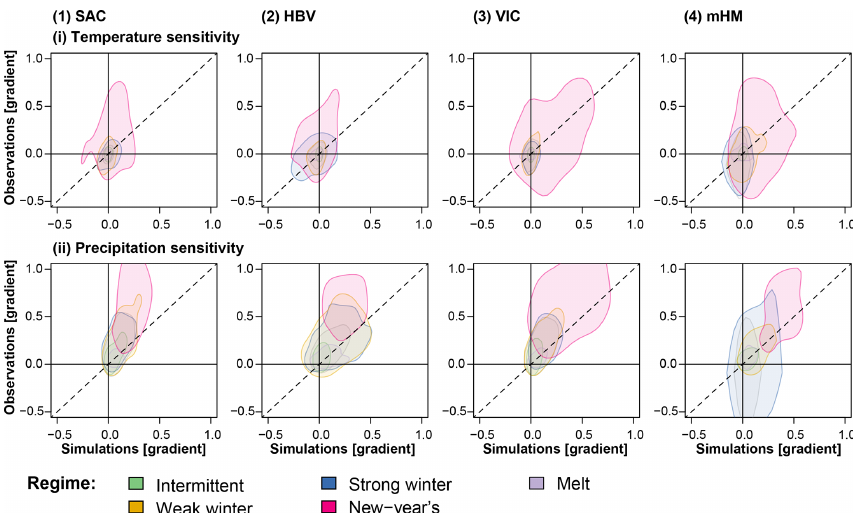
Figure 7. Observed vs. simulated (i) horizontal (temperature) and (ii) vertical (precipitation) climate sensitivities for floods represented by two-dimensional kernel density estimates for the four models (1) SAC, (2) HBV, (3) VIC, and (4) mHM for the five regime types: intermittent (114 catchments), weak winter (108), strong winter (176), New Year’s (50), and melt (40) (Fig. 1). Positive and negative values indicate positive and negative associations of precipitation and temperature with peak flow, respectively. Values on the dashed line indicate correspondence between observed and modeled sensitivity